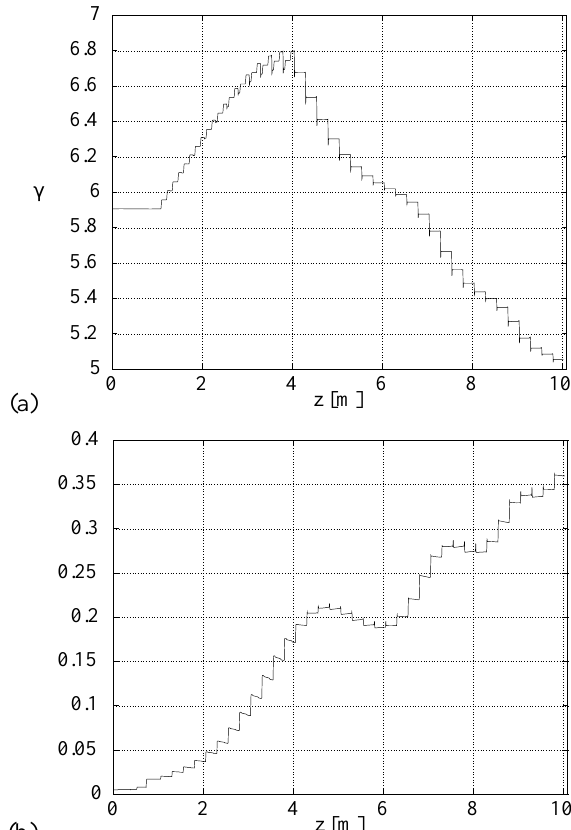
FIG. 16. (Color) Evolution of transverse rms envelopes (a) and normalized emittances (b) (horizontal: solid green line; vertical: dashed blue line) during afterburner operation.